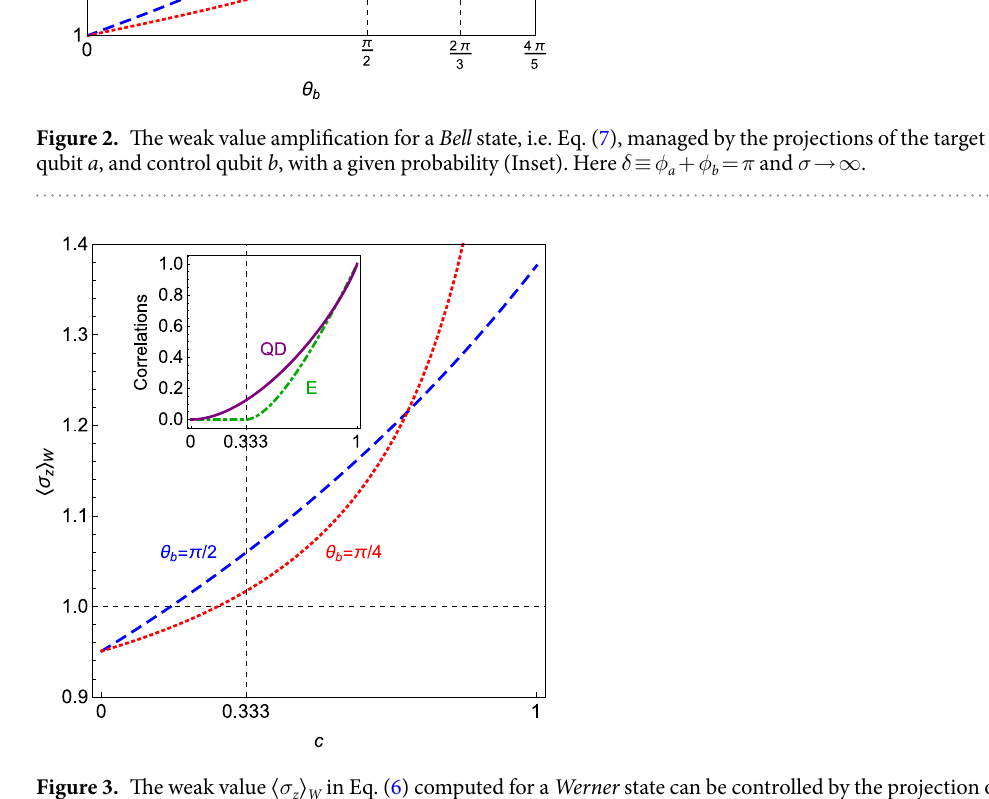
Figure 3. The weak value 〈 σ z 〉 W in Eq. (6) computed for a Werner state can be controlled by the projection of the control qubit b even for zero Entanglement ( E ) and non-zero Quantum Discord ( QD ) between the qubits (see Inset). The parameters are θ a = π /10, φ a = φ b = 0 and σ → ∞